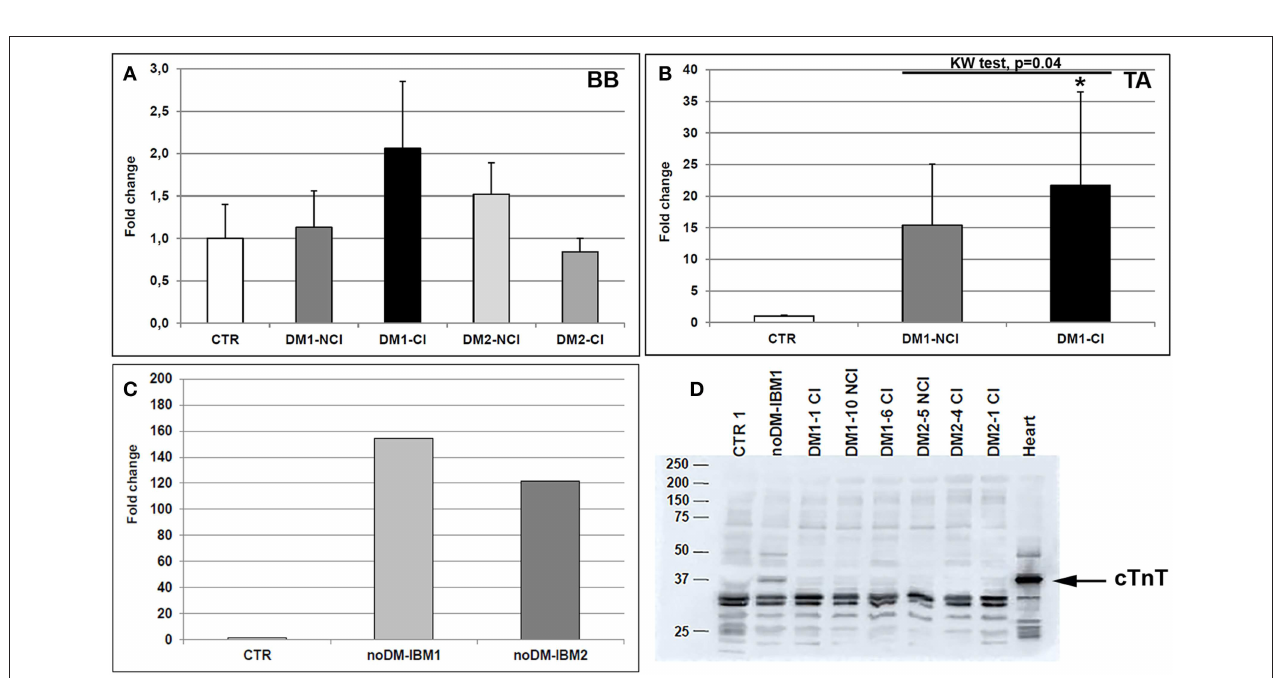
FIGURE 1 | and investigated proteins are indicated. Both DM1 and DM2 show a high fiber size variability (A,D,G,L,O,R) . In DM1 atrophic fibers (black arrow) and nuclear clumps (black arrowhead) are both fast (brown fibers) or slow fibers (unstained fibers) (B,E,P,S) while in DM2, essentially all atrophic fibers (black arrow) and nuclear clumps (black arrowhead) are identified as fast fibers (brown fibers; H,M ). Only few atrophic fibers (brown fibers) and almost all nuclear clumps (white arrow) express MyHC-neo (C,F,I,N,Q,T) . In the noDM-IBM patient, skeletal muscle shows the presence of numerous atrophic fibers, both fast and slow myosin positive, and